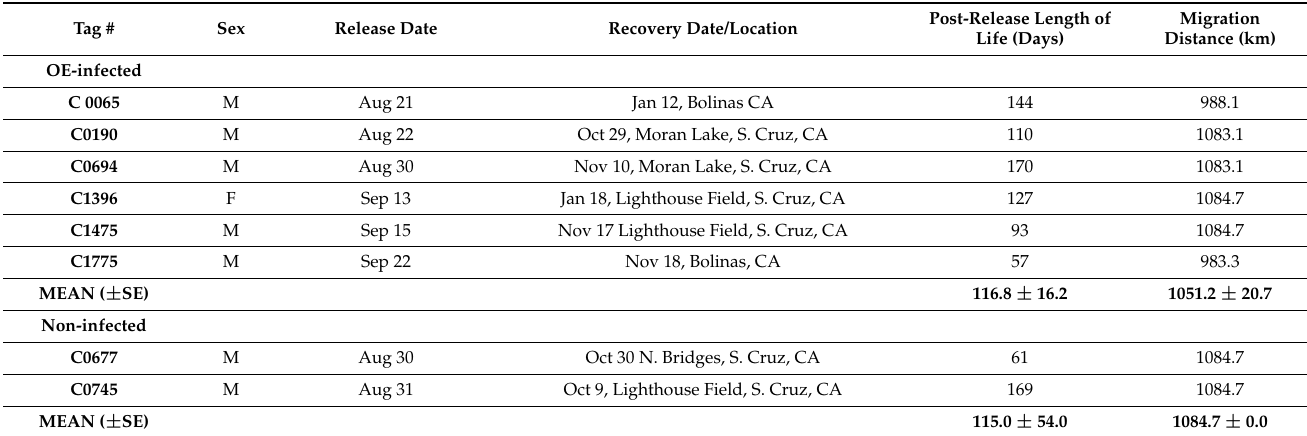
Table 11. Length of life and migration distances of captive-reared tagged Ophryocystis elektroscirrha (OE)-infected and uninfected monarchs released from Yakima, WA during August–September 2017. All recoveries made at overwintering sites in